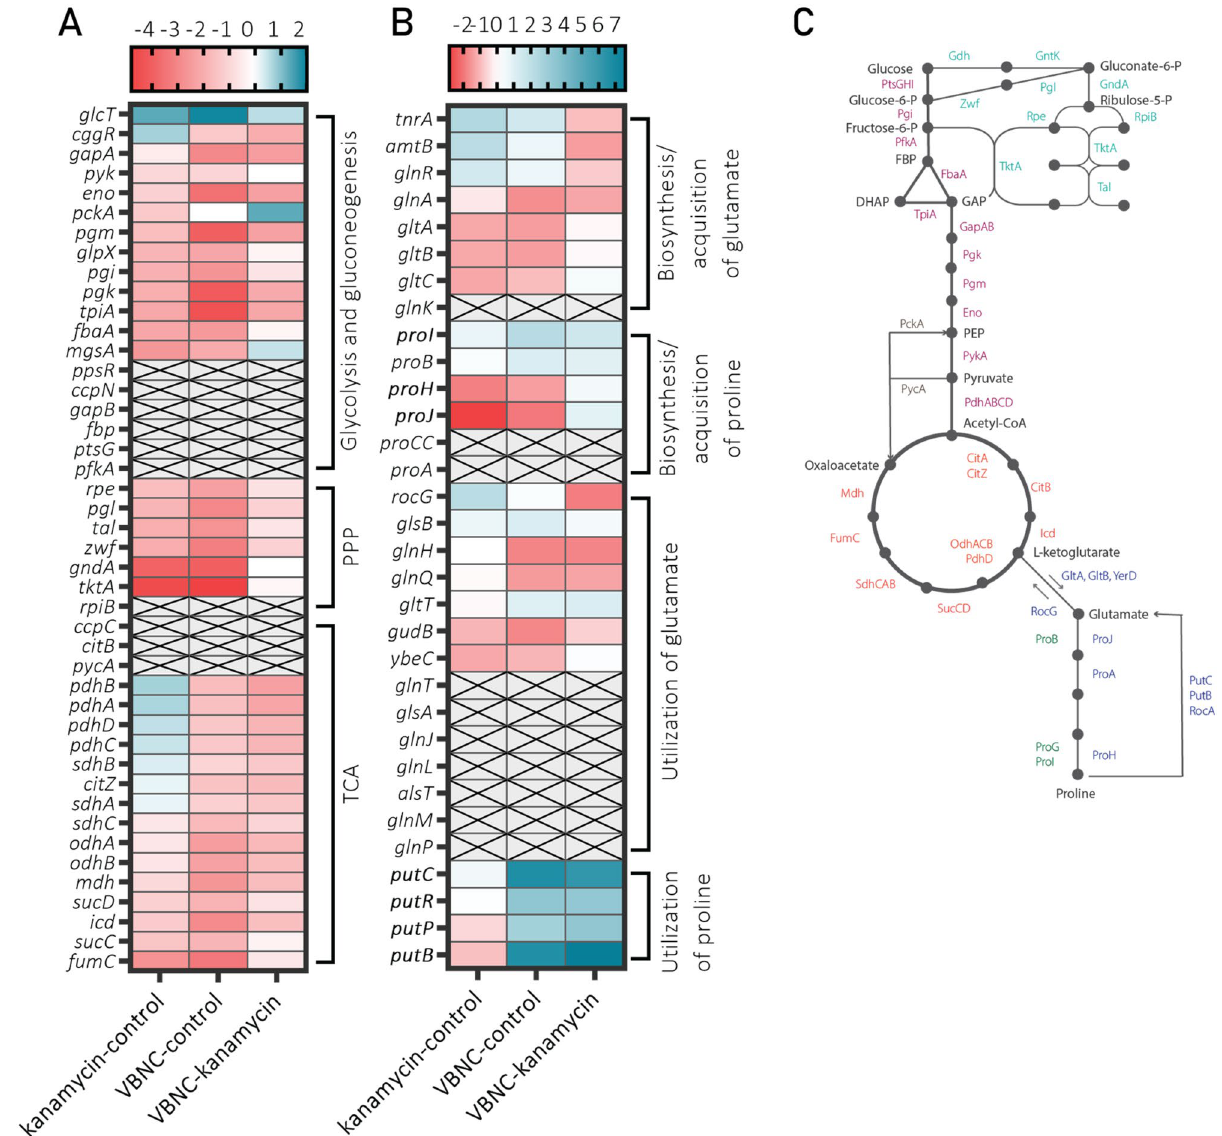
Figure 9. Changes in central metabolism in VBNC cells versus kanamycin-sensitive cells. Heatmaps of TopHits of DGEs ratio values ( p value ≤ 0.05 and a log 2 FC ≥ 2) for ( A ) central metabolism genes and ( B ) proline and glutamate metabolism. ( C ) depicts the TCA cycle, glycolysis, PPP and proline metabolism in B. subtilis 168. Heatmaps were generated in GraphPad Prism 8 Software (GraphPad Software, San Diego, California USA, www. graph pad.